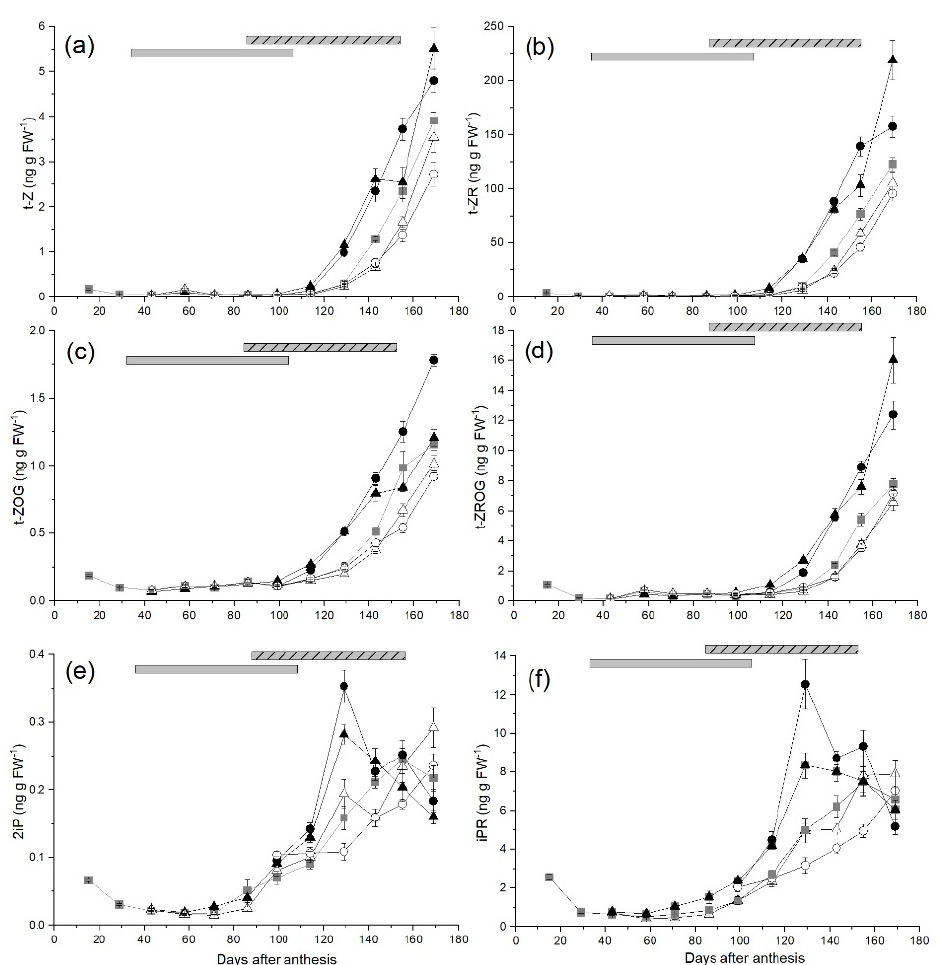
Figure 4. The effect of time of manipulation of carbohydrate supply together with phloem girdling on ( a ) trans -zeatin (t-Z) ( b ) trans -zeatin-O-glucoside (t-ZOG) ( c ) isopentenyl adenine (2iP) ( d ) isopentenyl adenine riboside (iPR), ( e ) trans -zeatin riboside (t-ZR) and ( f ) trans -zeatin riboside-O-glucoside (t-ZROG) concentration of Actinidia chinensis var. chinensis ‘Zesy002’, kiwifruit, from anthesis through to harvest. Data are shown for ungirdled control canes ( (cid:4) ), early girdled canes with high ( (cid:78) ) or low ( (cid:52) ) carbohydrate supply or late girdled canes with high ( • ) or low ( ) carbohydrate supply. Early treatments were applied at 38 days after anthesis with the duration of the open girdle shown by the grey solid bar at the top of each panel. Late treatments were applied at 86 days after anthesis with the duration of the open girdle shown by the grey/black stripped bar at the top of each panel. High carbohydrate supply treatments had six leaves per fruit, while low carbohydrate supply treatments had one or two leaves per fruit. Data are means ± SEM, n = 5.